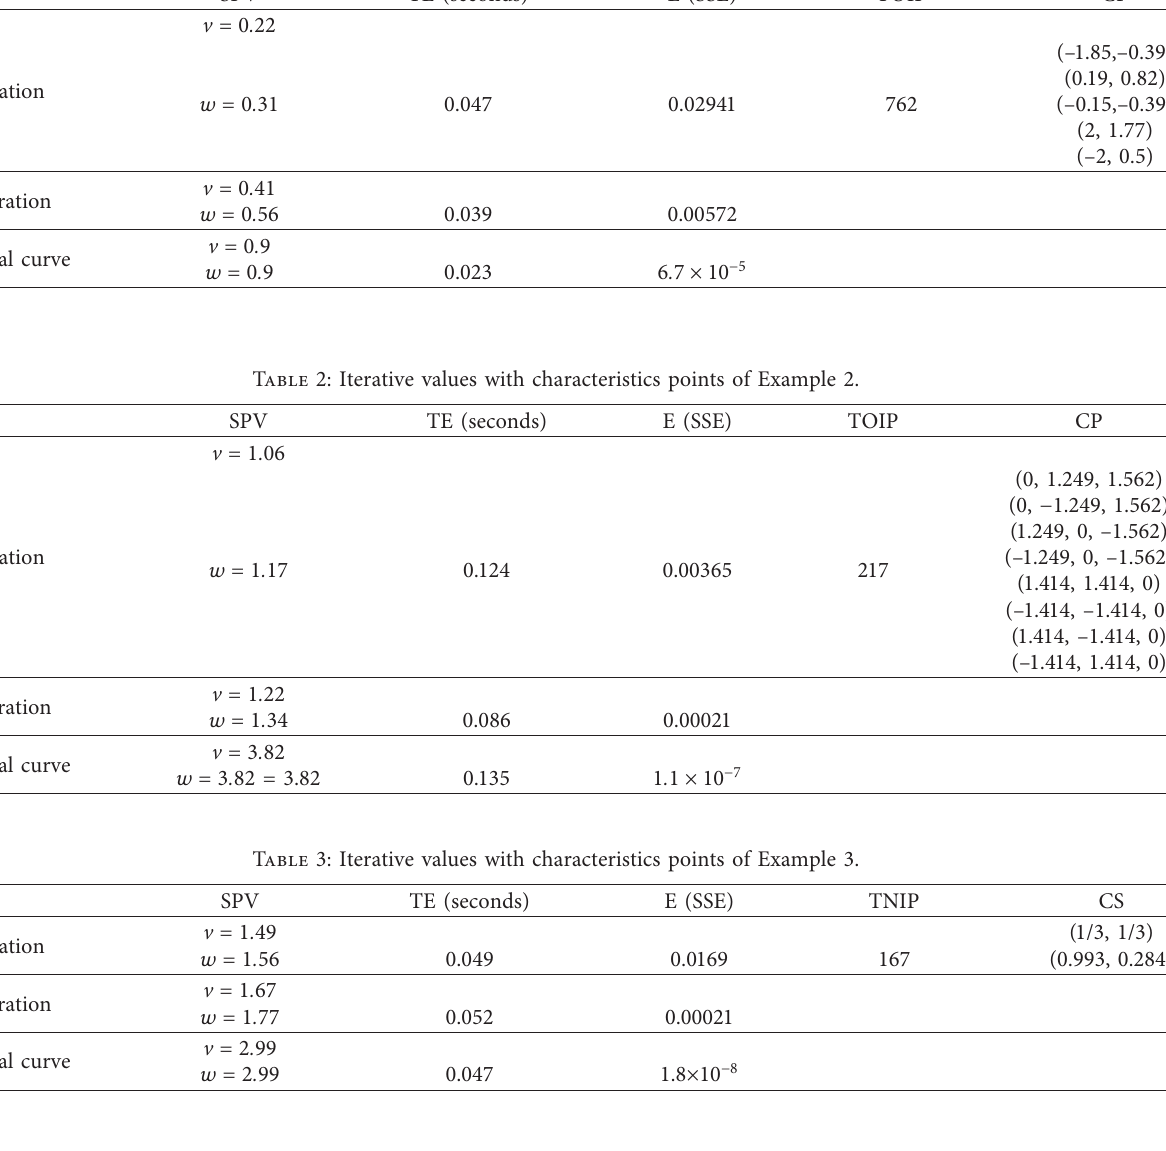
Table 4: Parameters utilized for